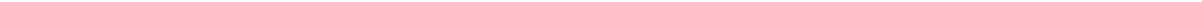
controls: normal BA in n = 58/58 by tbx1 reporter and n = 10/10 by DAR-4M, total n = 68/68, N = 4. Scale bars 50 µ m ( g , o ), 100 μ m ( a – f , s – x